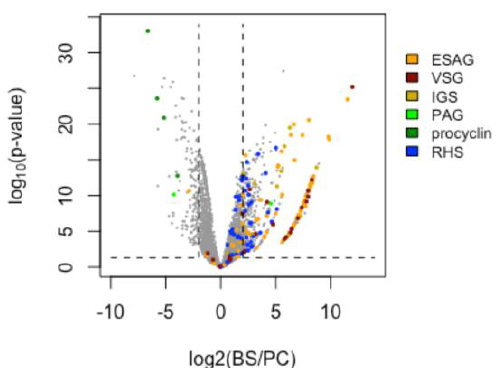
Figure 6. Volcano plot representation of differential gene expression between bloodstream-stage (BS) and procyclic-stage (PC) T. brucei . Transcripts for the stage-specific surface proteins procyclin, the variant or invariant surface glycoproteins VSG and ISG, expression site-associated genes (ESAG), procyclin-associated genes (PAG), and retrotransposon hotspot proteins (RHS) are colored as indicated. Dashed vertical lines: fold changes (BS/PC). >4 or < − 4. Dashed horizontal line: p -value < 0.05.